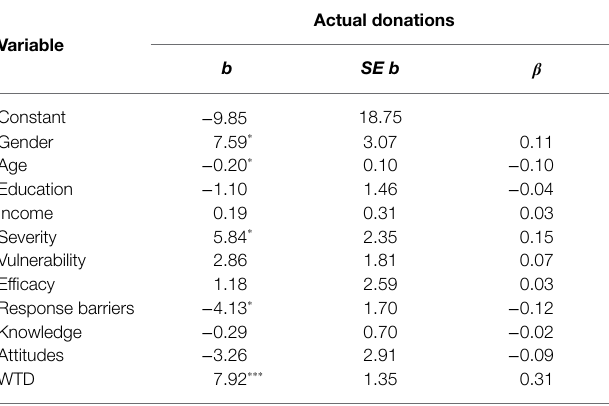
TABLE 4 | Additional step of the multiple hierarchical regression including the influence of willingness to donate on actual donations to insect conservation ( N =